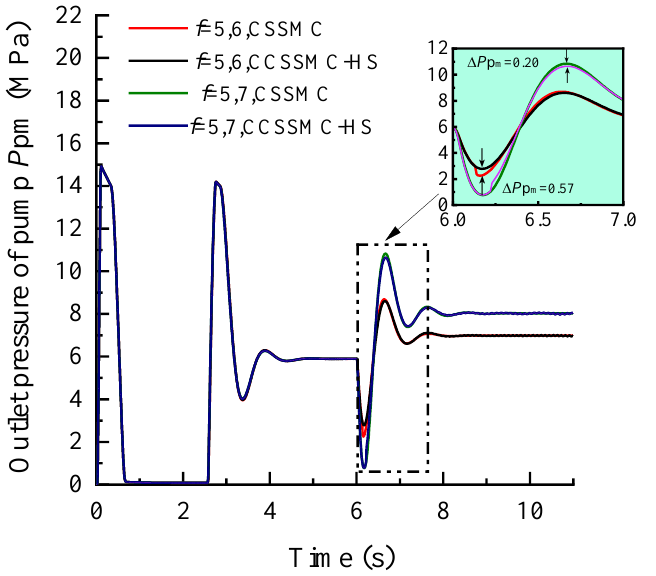
Figure 16. Variation curve of the hydraulic pump outlet pressure based on the CSSMC and CSSMC-HS.